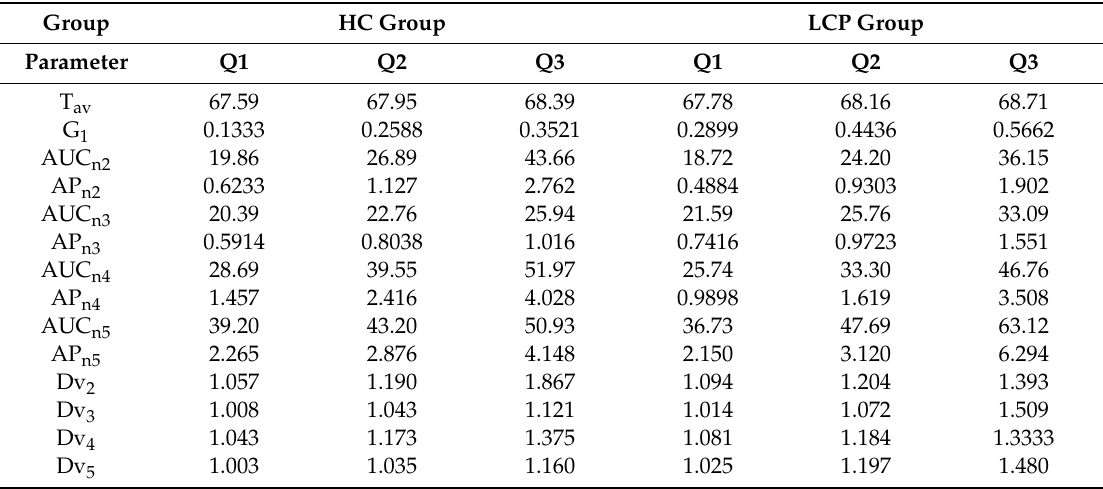
Table 1. Quartiles of individual thermal liquid biopsy (TLB)-derived parameters in healthy control (HC) and lung cancer patient (LCP) groups.